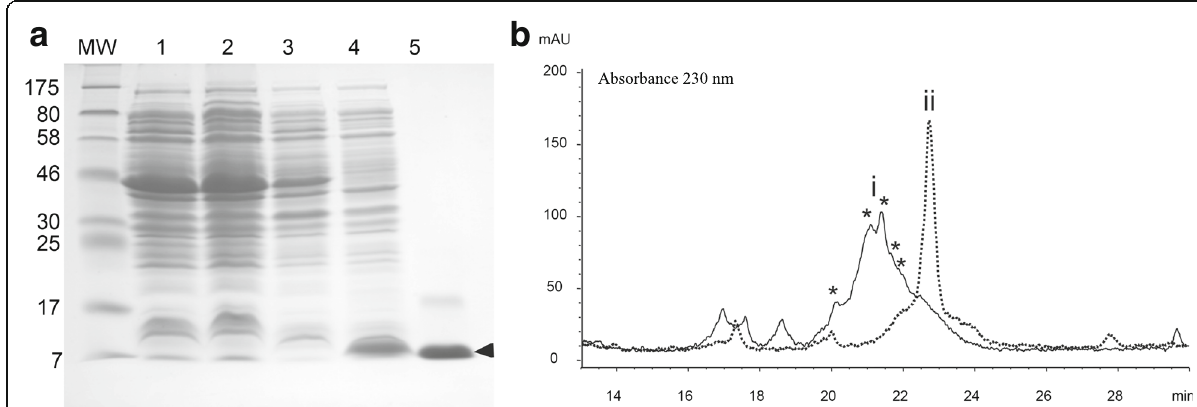
Fig. 2 SDS-PAGE and HPLC separation of HisrMlat1 from M15 strain cells. a SDS-PAGE. Left lane shows the molecular weight markers (kDa). Lane 1: the cell protein content that has the pQE30 vector without the HisrMlat1 gene and without IPTG induction. Lane 2: the cell protein content that has the pQE30 vector without the HisrMlat1 gene after 0.1 mM IPTG induction. Lane 3: the cell protein content that has the pQE30 vector with the HisrMlat1 gene and without IPTG induction. Lane 4: the cell protein content that has the pQE30 vector with the HisrMlat1 gene and with 0.1 mM IPTG induction. Lane 5: the protein after purification by affinity column (upper bands are oligomers of HisrMlat1). The protein band corresponding to HisrMlat1 is indicated by an arrow. b rpHPLC. The product obtained from the affinity column was directly loaded into the C 18 reverse column (approx. 100 μ g of protein). The fractions labeled with an asterisk had the molecular mass expected for the recombinant HisrMlat1 (label i). None of the fractions were lethal to mice. The pooled multiple oxidized fractions (100 μ g of protein, label i) were reduced with DTT, and loaded into the same rpHPLC. Superimposed on this chromatogram is the profile of the reduced HisrMlat1 (label ii)